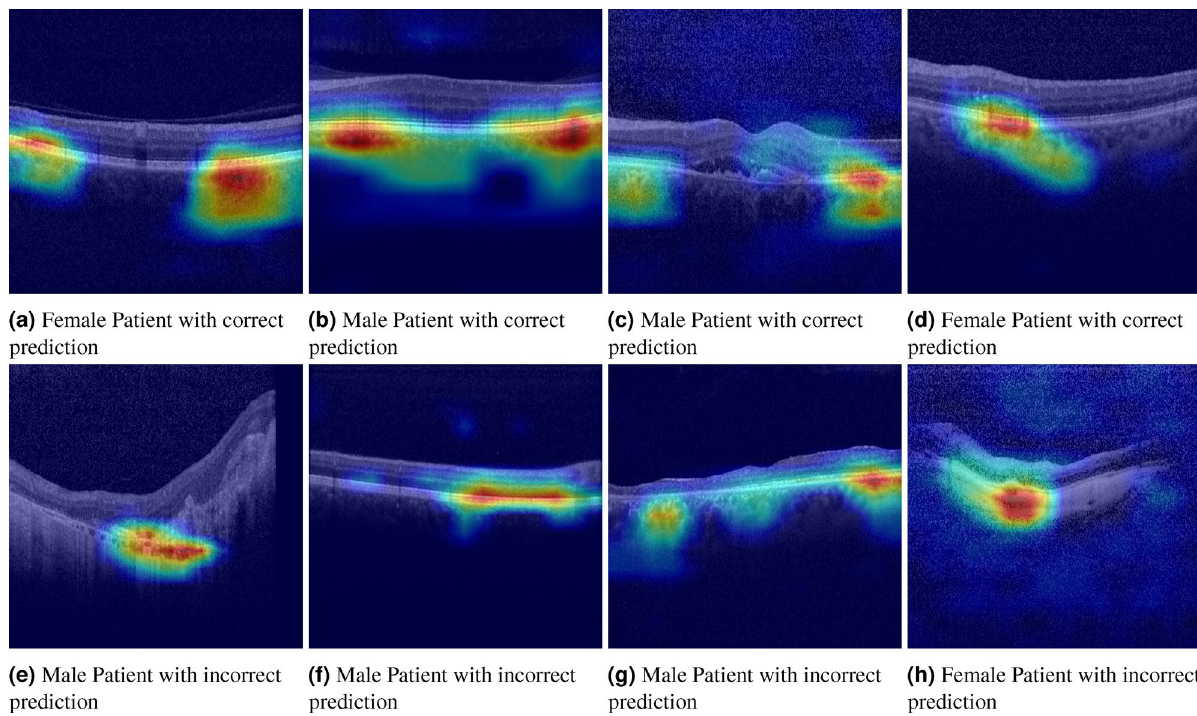
Figure 8. Attention maps of OCT BScans, top row: correct predictions, bottom row: incorrect predictions.